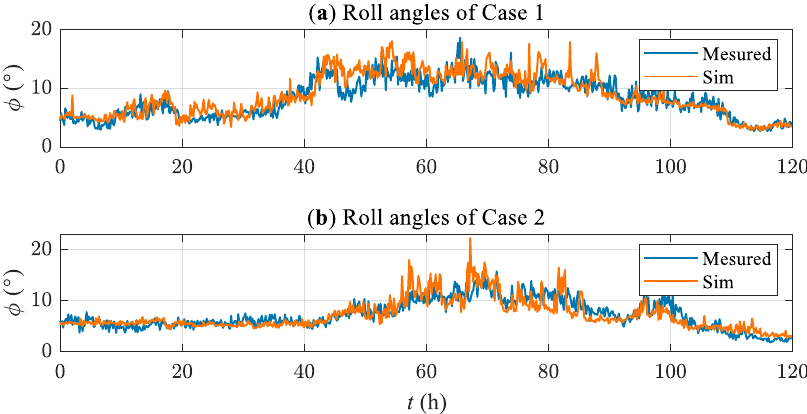
Figure 3. Validation of simulated rolling motion. ( a ) simulated roll angles of case 1; ( b ) simulated roll angles of case 2.